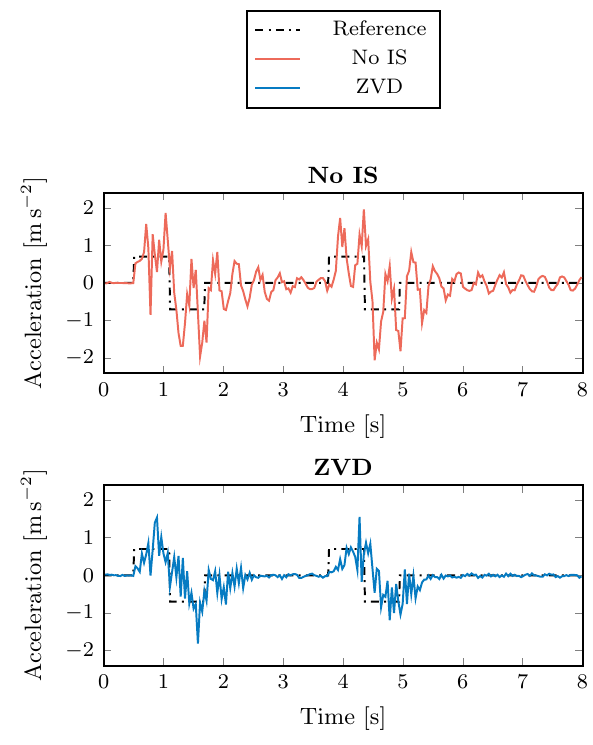
Figure 13: Acceleration measurements performed by an accelerometer placed right next to the 3D camera. The trajectory is performed in order to grab two 3D depth images of a ship propeller blade. The reference trajectory is shown in Figure